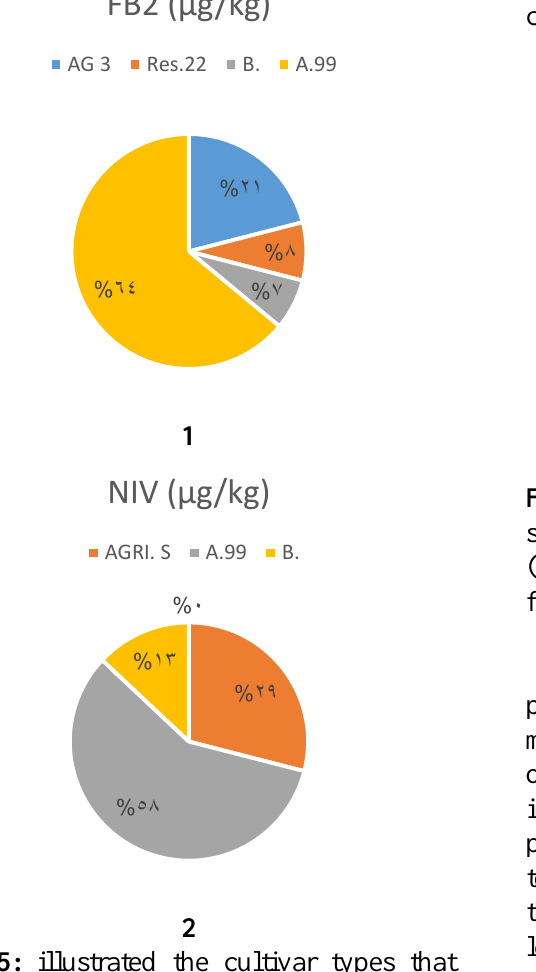
Figure, 5: illustrated the cultivar types that showed concentration rates of mycotoxins (1) FB2 and (2) NIV as percentages in the 17 selected wheat fields in the south of Iraq/ Basra province. Whereas, for DON mycotoxin, the Ebaa 99 (E.99) cultivar was on the top, which occurred in 6 fields ranging from 8-1060 µg/Kg with an average percentage of 43% (Fig.6).